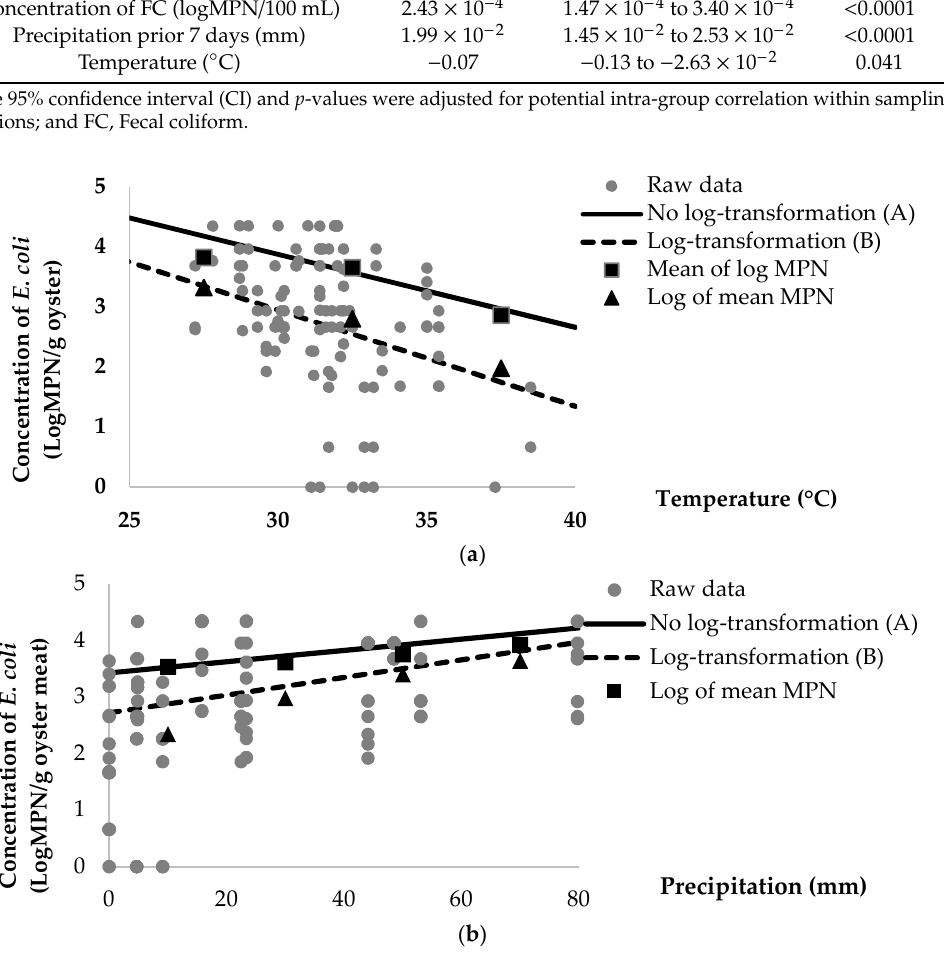
Figure 1. Predicted average population of E. coli /g of pooled oyster meat as a function of ( a ) ambient air temperature and ( b ) 7-day average precipitation between no log-transformed (Model A) and log-transformed (Model B) data.